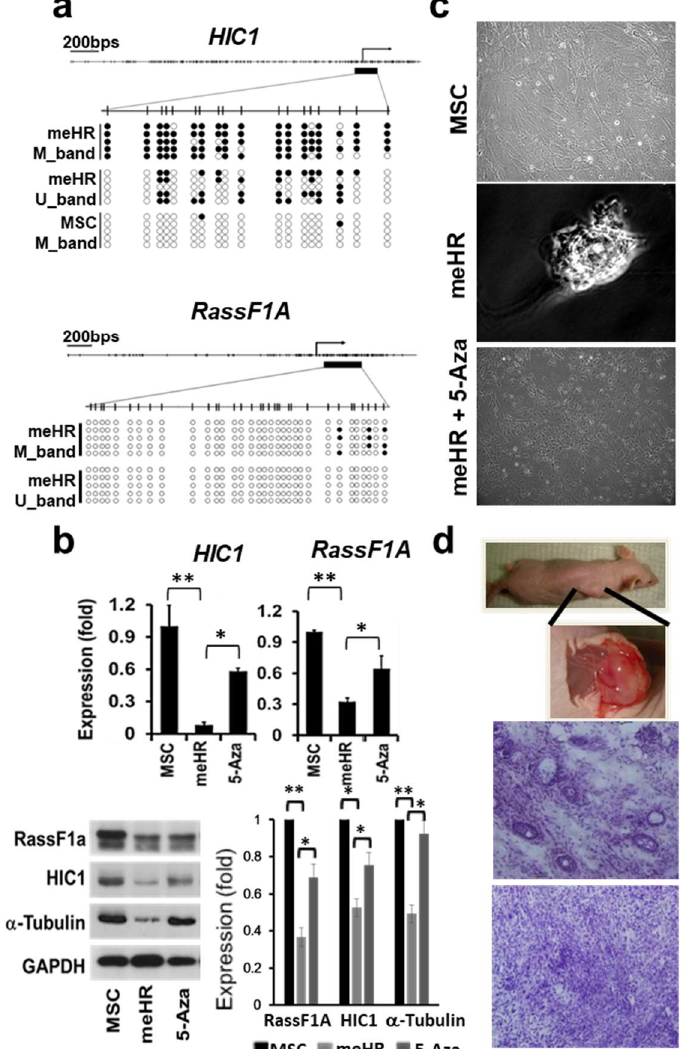
Figure 1. Targeted HIC1 and RassF1A methylation transforms mesenchymal stem cells (MSCs). ( a ) Validation of targeted HIC1 and RassF1A methylation. Targeted DNA methylation in HIC1 and RassF1A was validated by sequencing methylation-specific polymerase chain reaction (PCR) products and pyrosequencing, respectively. Vertical short bars within physical maps indicated the CpG loci and their methylation percentages were revealed by the filled density in circles. U-band: methylation-specific polymerase chain reaction amplified by unmethylated primers; M-band: methylation specific PCR (MSP) amplified by methylated primers. ( b ) Targeted HIC1 and RassF1A methylation reduced expression, reversed by 5-aza-2′-deoxycytidine (5-Aza) treatment. Targeted HIC1 and RassF1A methylation reduced their respective gene expression as detected through semi-quantitative reverse transcription PCR (top) and Western blotting (lower two, right panel indicates the quantitative summaries of the repeated Western blots on the left) experiments in me_HR. The methylation-silenced gene expression was reversed in the me_HR-transformed MSCs after 5 days using 5-Aza treatment (5 μM). ( c ) Loss of contact inhibition in me_HR-transformed MSCs. MSCs